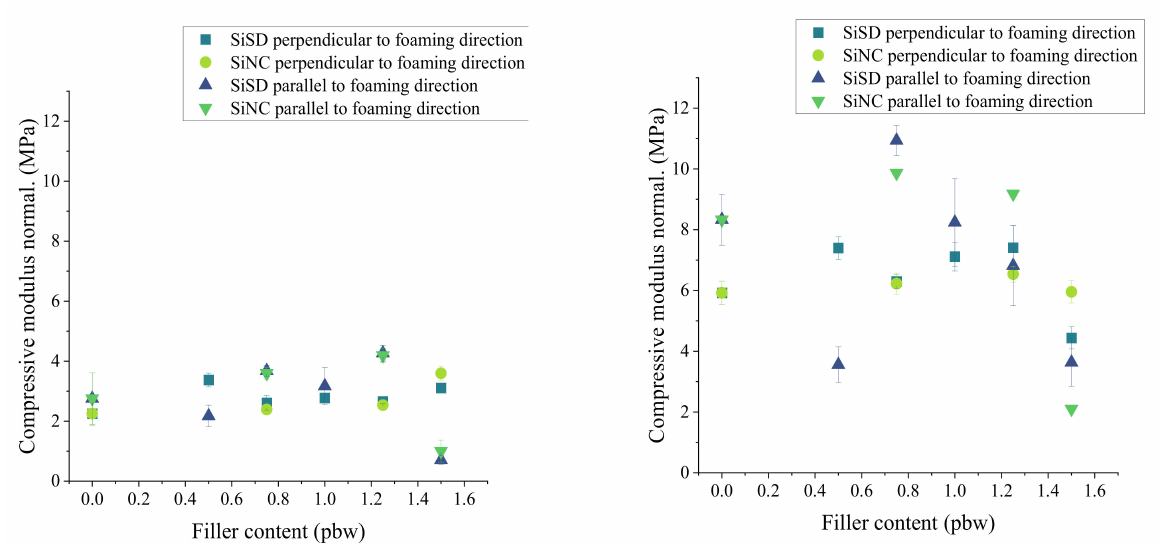
Figure 13. The compressive modulus of PP40 composites with 0.5–1.25% filler concentration at RT ( left ) and 77 K ( right ).